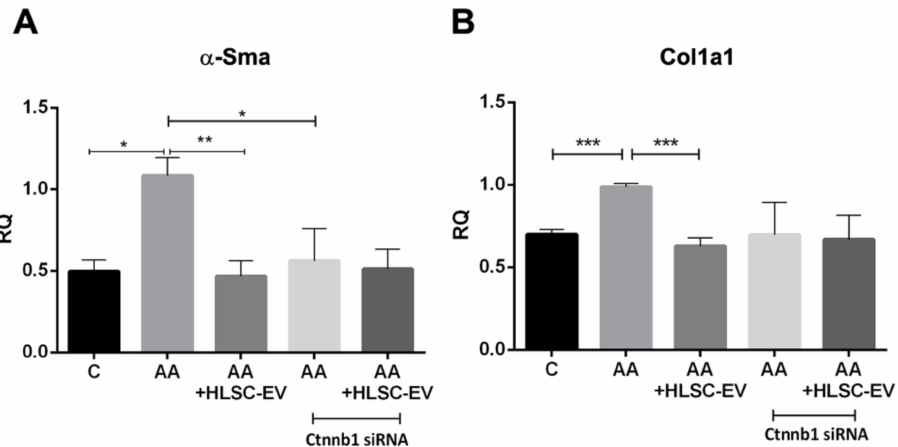
Figure 6. Silencing of β -catenin prevents the up-regulation of profibrotic genes in fibroblasts in vitro. mTECs pre-treated with 100 µ M AA for 4 h were co-cultured with mkCF or mkCF silenced for the Ctnnb1 gene in the presence or absence of HLSC-EVs. Post-experimental analysis revealed a significant upregulation of the profibrotic genes α -Sma ( A ) and Col1a1 ( B ) in fibroblasts exposed to AA-treated mTECs, which was significantly reduced in the presence of HLSC-EVs. No significant up-regulation of both profibrotic genes was observed in fibroblast silenced for the Ctnnb1 gene, which codes for β -catenin in the presence or absence of HLSC-EVs, when compared to control. Data represent the mean ± SD of three independent experiments. A one-way ANOVA with Bon- ferroni’s comparison test was performed. * p < 0.05, ** p < 0.01, *** p < 0.001 was considered to be statistically